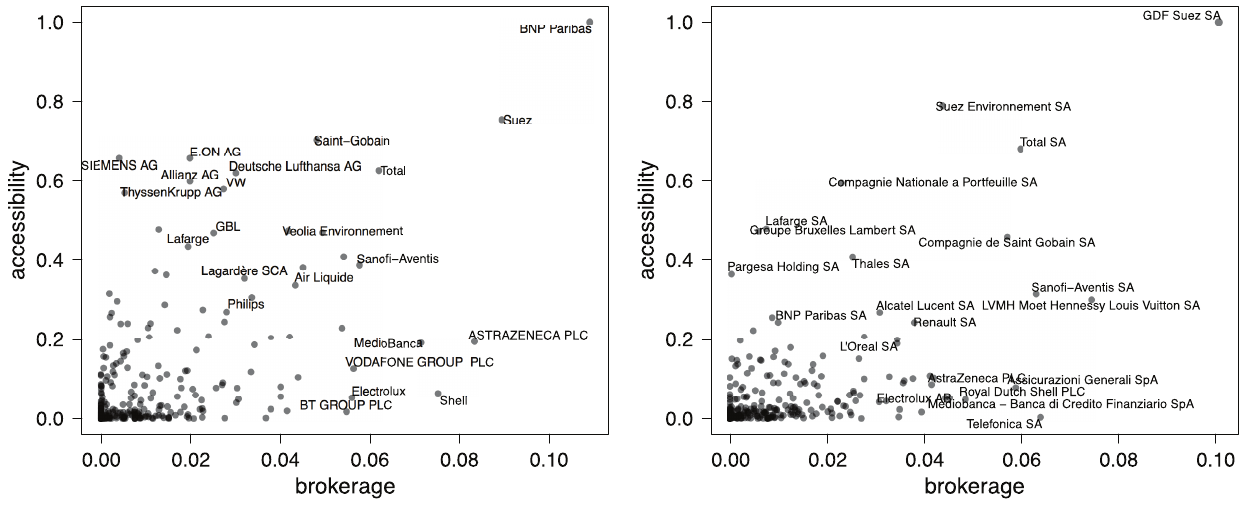
Figure 4. Centrality measures on the boards projection in 2005 (Left) and 2010 (Right). Each point in the plane corresponds to a company; x and y coordinates define its betweenness (here renamed brokerage), and eigenvector centrality (here called accessibility) scores, respectively. Due to readability reasons, only those who rank higher are labeled (refer to Tables 2 and 3).